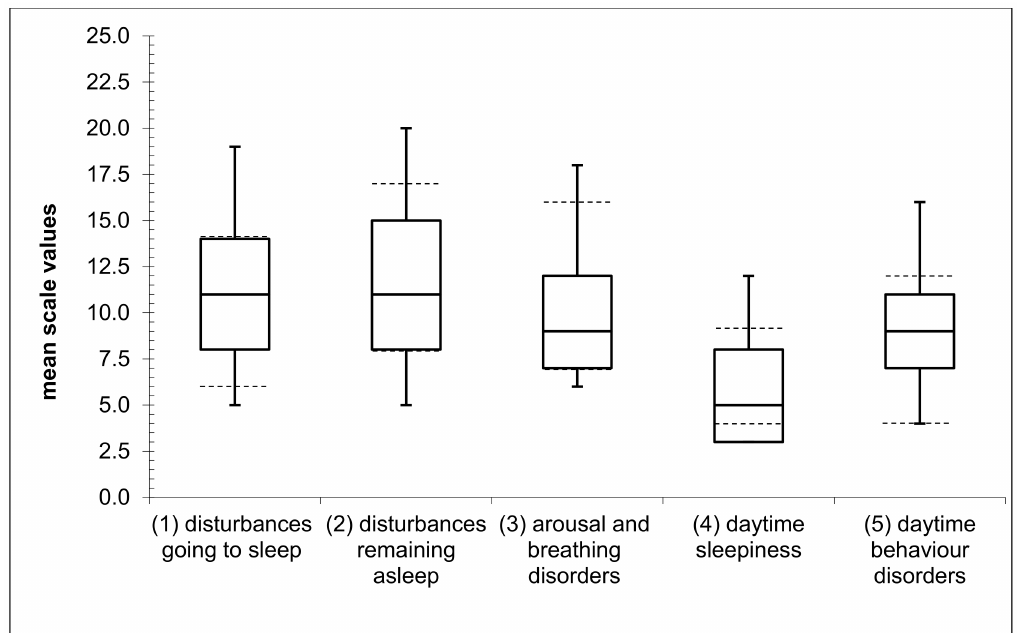
Figure 1. Box plot diagram for Sleep Questionnaire for Children with Severe Psychomotor Impairment (SNAKE) scales 1–5 (dashed lines indicate the upper and lower ends of the respective normal range).